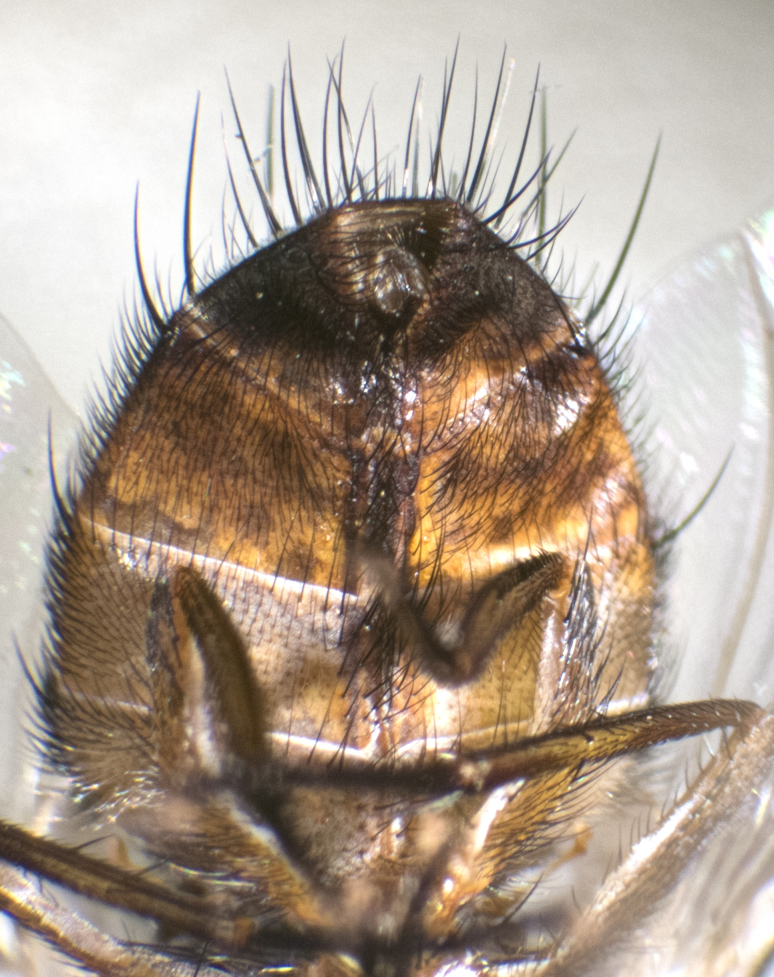
Ventral view of abdomen in Hyphantrophaga
albopilosa
sp. n. showing presence of sex patches on T4 and T5